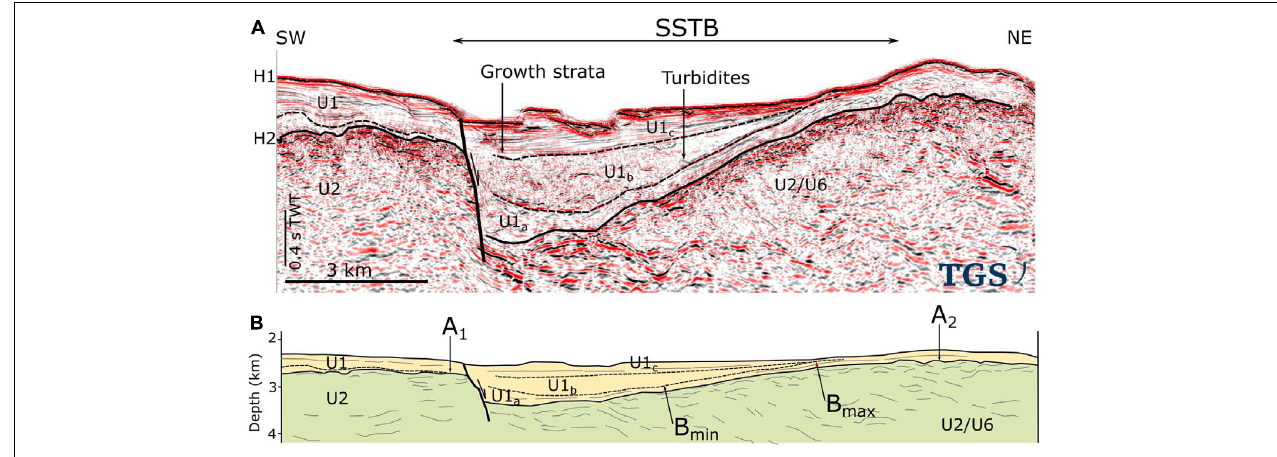
FIGURE 9 | (A) Seismo-stratigraphic detail of Section A in Figure 5 . (B) Depth-converted line drawing. A1 and A2 are two points of measurement of the U1 succession taken far away from the shallow fault that controls the syn-tectonic Pliocene-Holocene basin (SSTB). Bmin and Bmax represent the minimum and maximum thickness, respectively, of U1a in which the reflectors are subparallel to the Top Messinian horizon. Refer to the text, Figure 2B , and Table 2 for the description of the involved horizons and